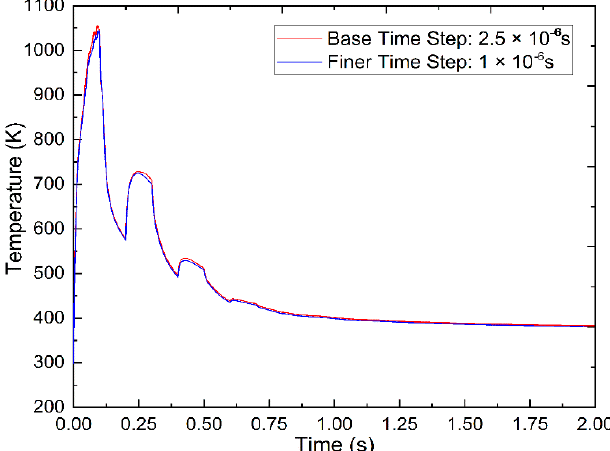
Figure 6. Temperature variation at a specified position for time step sensitivity study.